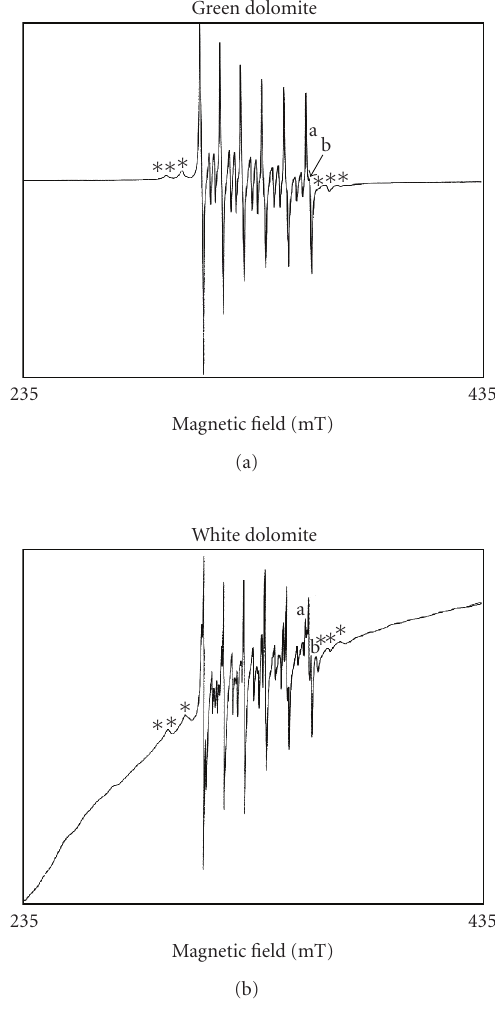
Figure 1: (a) EPR spectrum of green dolomite at RT ( v = 9 . 39219 GHz). (b) EPR spectrum of white dolomite at RT ( v = 9 . 39208 GHz).